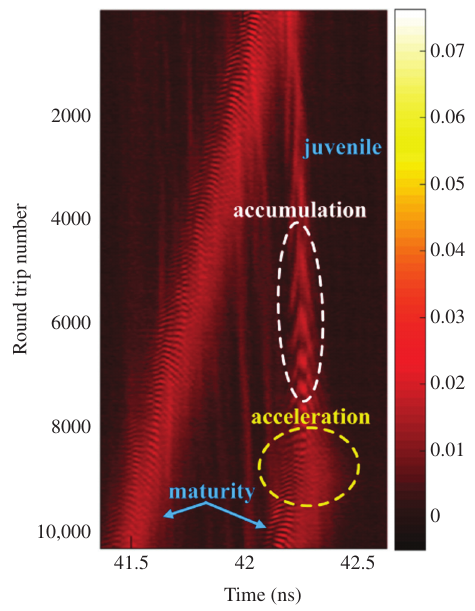
Figure 6: Spatio-spectral evolution of the deuterogenic solitons based on TS-DFT